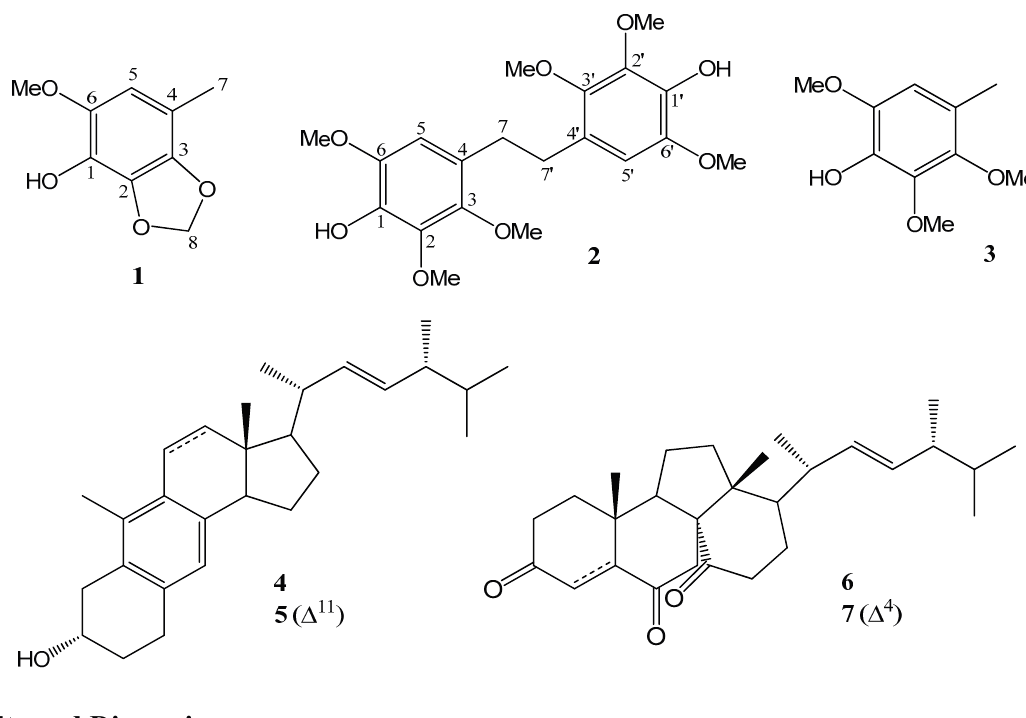
Figure 1. Chemical structures of 1 – 7 isolated in this